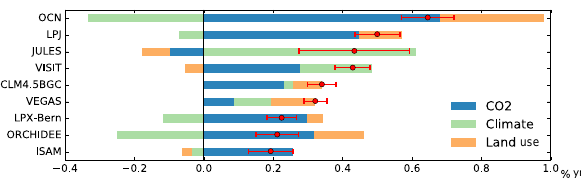
Figure 5. Attribution of the seasonal amplitude trend of global net land carbon flux for the period 1961–2012 to three key factors of CO 2 , climate and land use/cover. The red dots represent models’ global amplitude increase of F TA from the S3 experiment, and error bars indicate 1 σ standard deviation. The increasing seasonal ampli- tude of F TA is decomposed into the influence of time-varying atmo- spheric CO 2 (blue), climate (light green) and land use/cover change